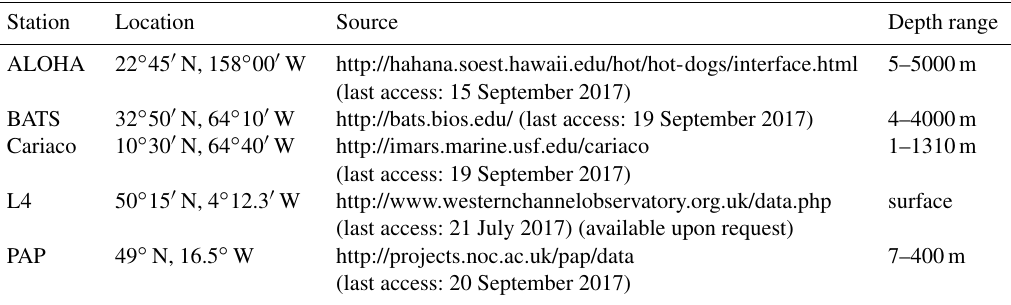
Table 2. Location, data source, and available depth range for the five oceanographic